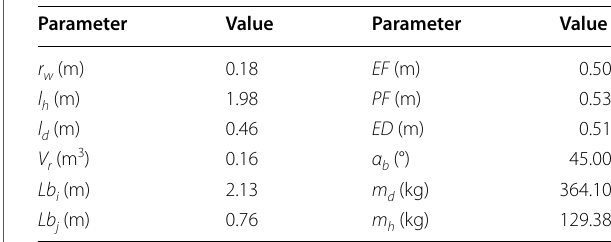
Table 4 Structural parameters of the ECS prototype working